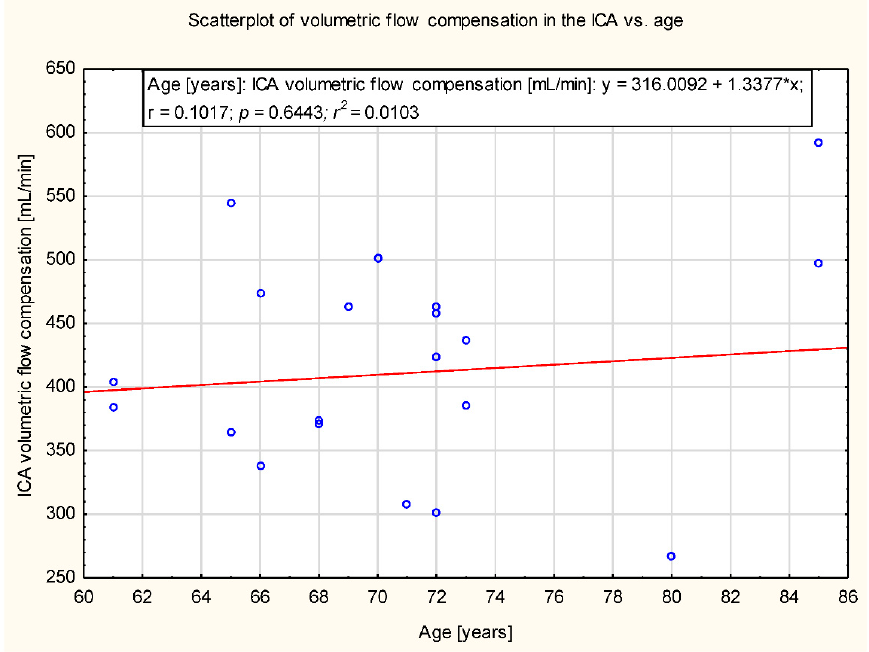
Figure 5. Scatter plot of the volumetric flow compensation in ICA and age (y = 316.0092 + 1.33778x). No correlation was observed ( p = 0.64). Scatterplot of volumetric flow compensation in the ECA vs. age